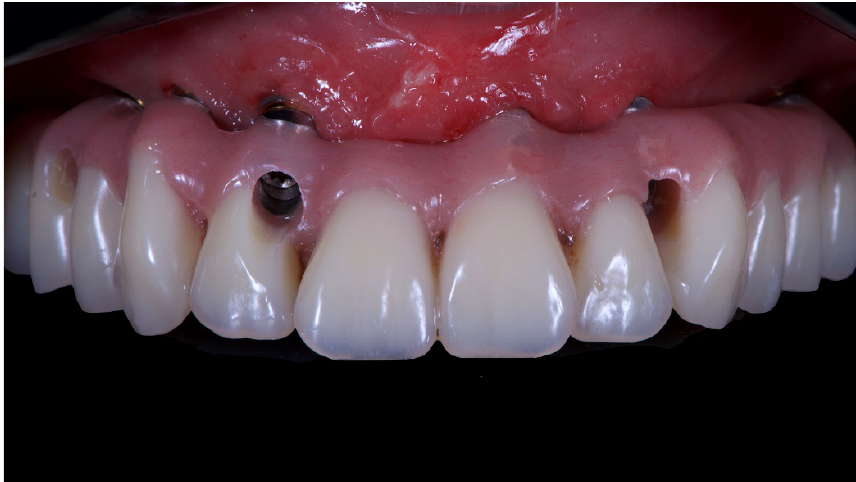
Figure 13. Final prosthesis mounted. Note the through holes. In two cases, it was compensated with only the Seeger , without a through screw.